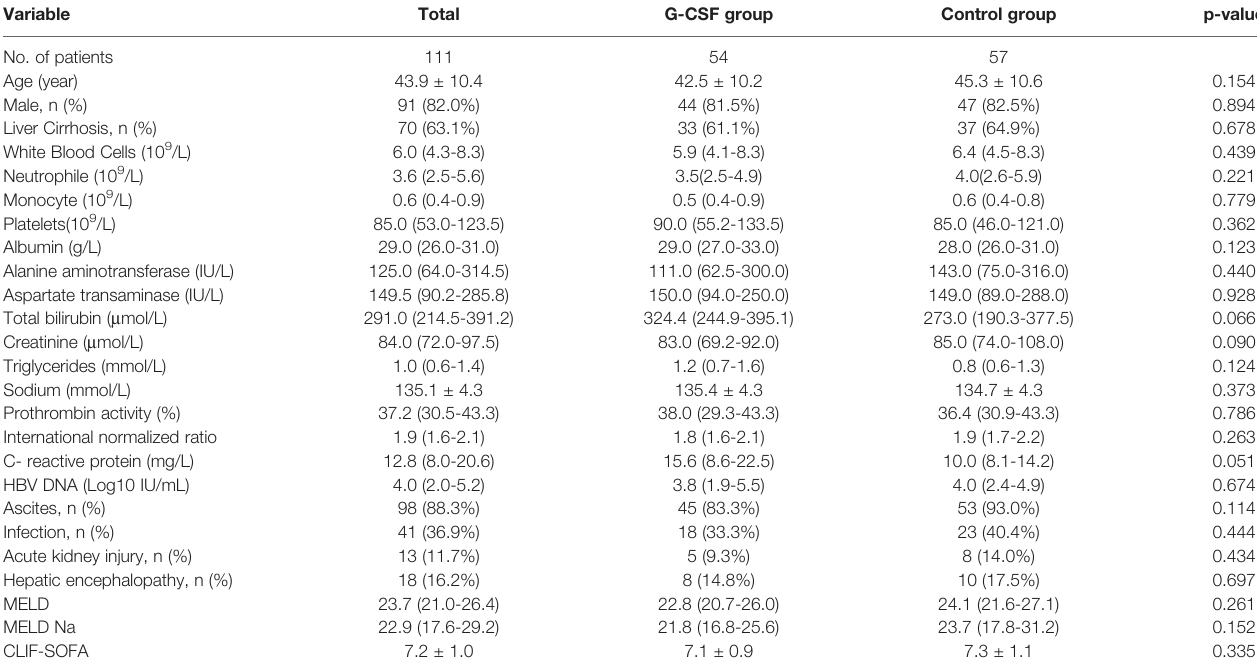
TABLE 1 | Demographical and clinical characteristic of patients in control and G-CSF Group.